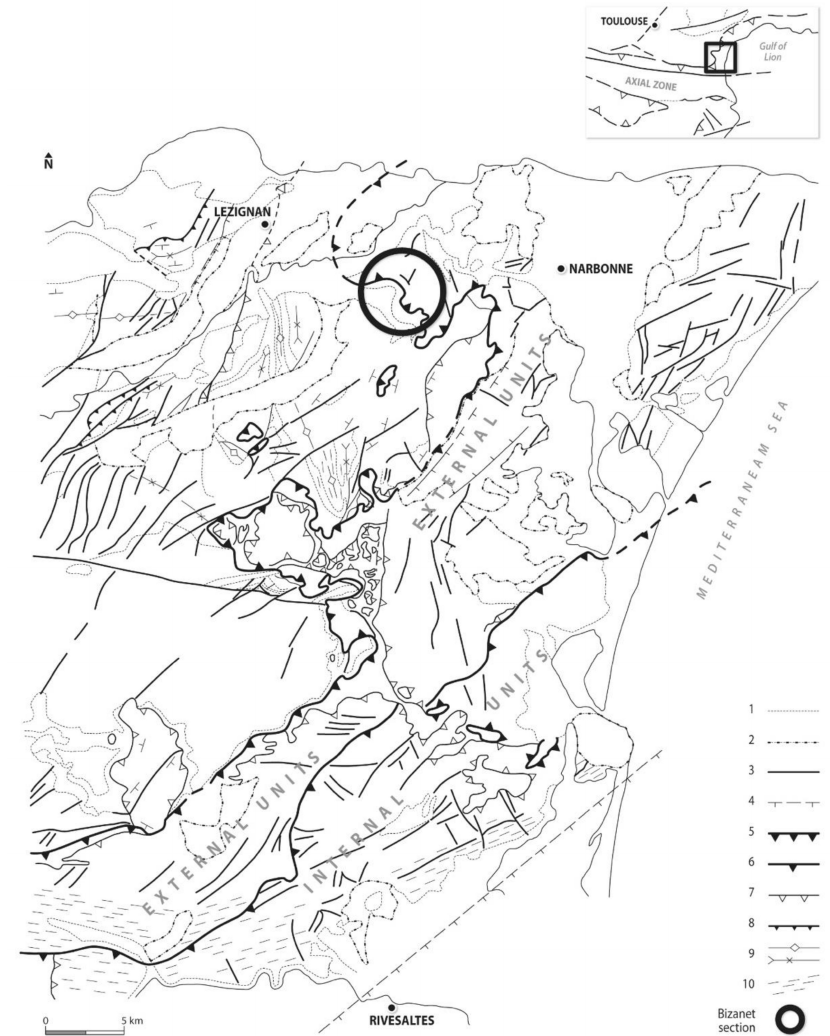
Figure 10. Simplified structural map of the Corbi è res nappe with the location of the Bizanet sec- tion (modified from Viallard [35]). 1: pre-Oligocene stratigraphic contact; 2: post-nappe terranes; 3: subvertical fault; 4: main normal fault; 5: basal contact in allochthonous units; 6: frontal thrusts in internal units; 7: tangential shear surface; 8: foreland thrusts; 9: folds axis; 10: